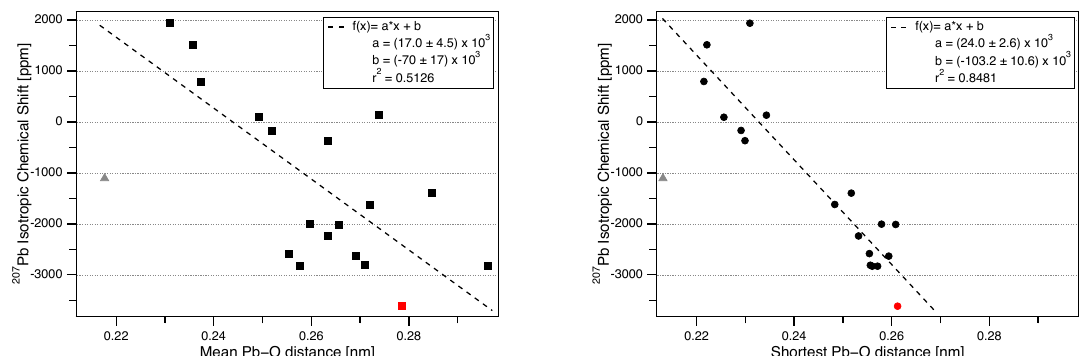
Figure 6. ( Left ) Evolution of 207 Pb isotropic chemical shift ( δ iso ) versus mean Pb–O distance for compounds where lead occurs solely in oxygen co-ordination, with anglesite shown in red. ( Right ) δ iso versus the shortest Pb–O distance. All data given in Table 2. (Dashed lines show the least-squares linear fit, with fit parameters and their errors given in the upper-right corners. The data point for Pb 4 + (1) in Pb 3 O 4 (Minium) is shown as a gray triangle and was not included in the least-square fits, as the correlation was restricted to only Pb 2 +